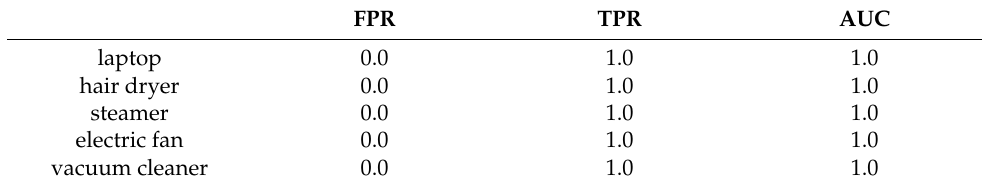
Table 4. Obtained TPRs vs. FPRs for ROC curves, by the well-trained and -tested feed-forward ANN applied on the class-imbalanced test data in this experiment, where for the five load classes’ AUCs obtained are also